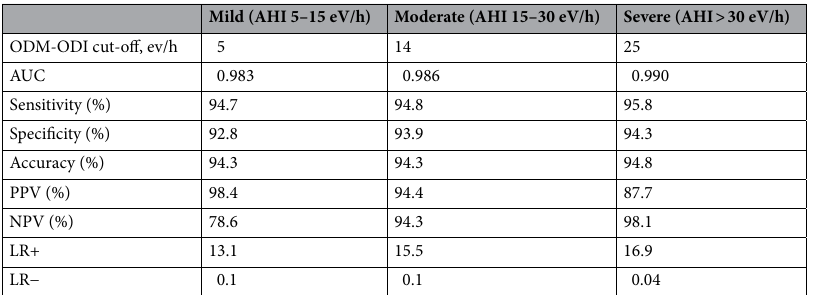
Table 3. Diagnostic performance of ODM-ODI using the best cut-off for detecting mild, moderate, and severe OSA diagnosed by HST. HST home sleep test, AHI apnea–hypopnea index, ODM overnight digital monitoring, ODI oxygen desaturation index, AUC area under the curve, PPV positive predictive value, NPV negative predictive value, LR + positive likelihood ratio, LR− negative likelihood ratio, ev/h